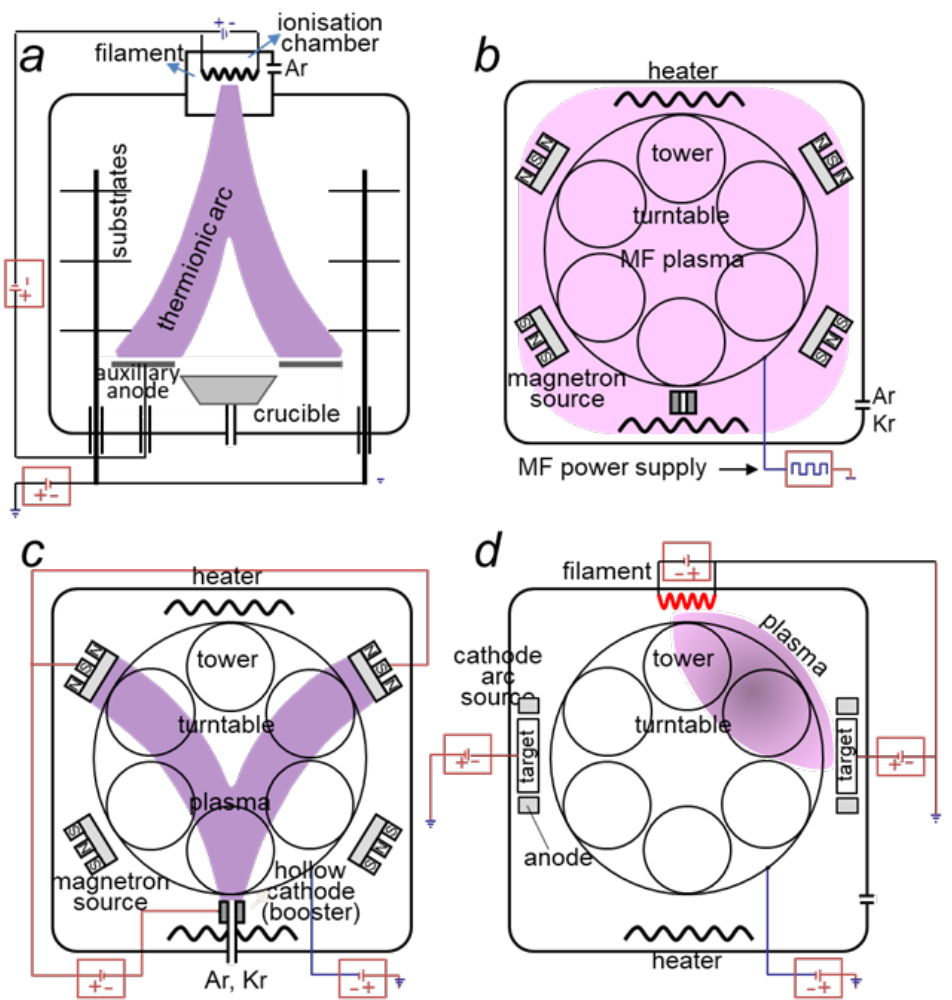
Figure 1. Schematic drawings of different deposition methods and ion etching modes used for the preparation of PVD hard coatings (the approximate area of plasma during the ion etching is marked by purple color) [17]: ( a ) side view of ion etching (DC bias) in low-voltage electron beam evaporation system BAI 730 (BAI); ( b ) top view of RF etching in magnetron sputtering system CC800/7 (CC7) and MF etching in CC800/9 sinOx ML (CC9); ( c ) top view of etching with hollow cathode plasma source (DC bias) in magnetron sputtering system CC9; ( d ) top view of ion etching (DC bias) cathodic arc deposition AIPocket (AIP).